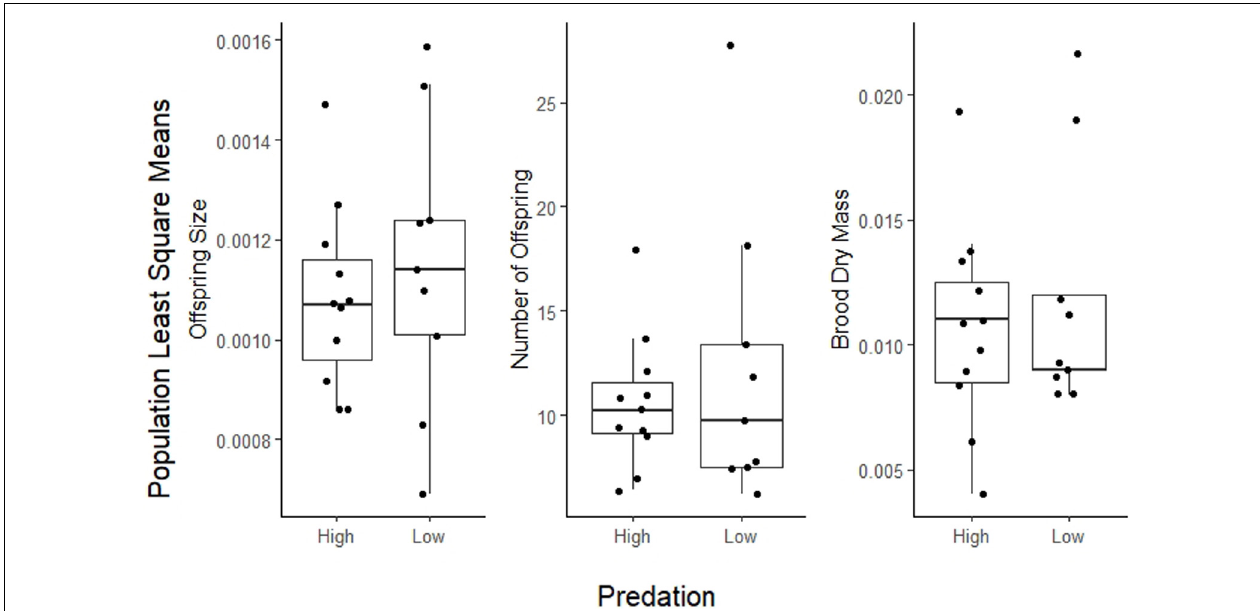
FIGURE 4 | Plot of size at maturity for males and females in high-predation and low-predation environments. Female size at maturity is the size where at least 1/2 females in that size category contain developing embryos. For males this is the mean size of mature males. Population points (dots) are jittered for better visualization.